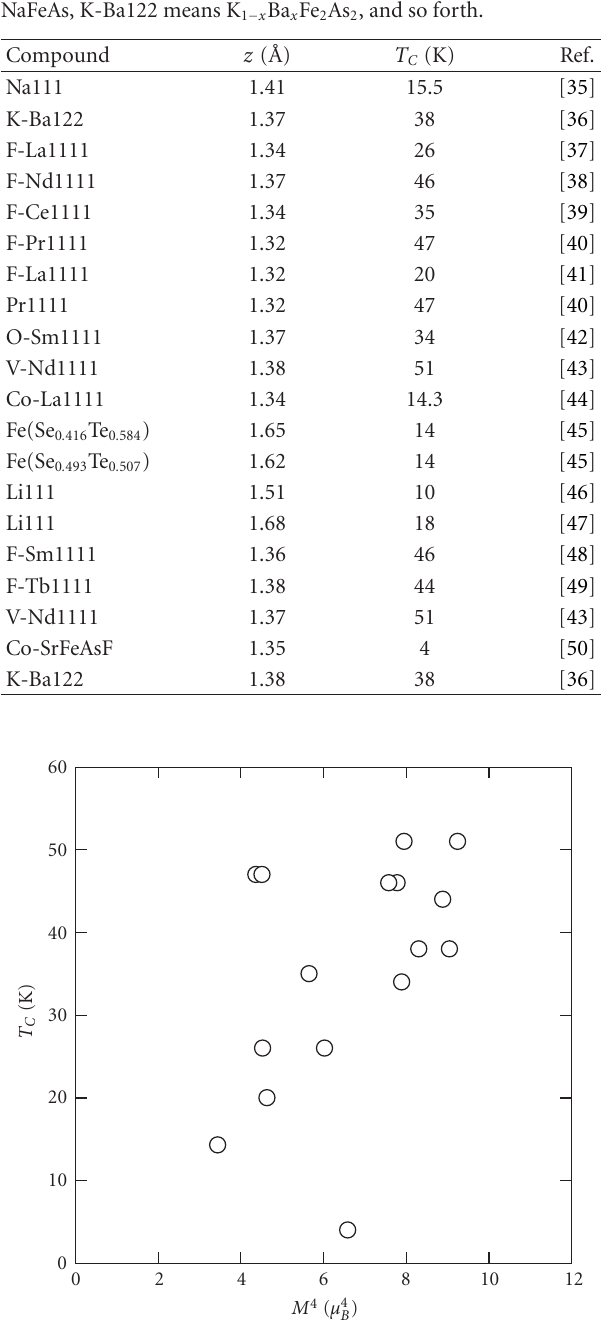
Figure 5: Superconducting critical temperature, T C , against M 4 calculated by the